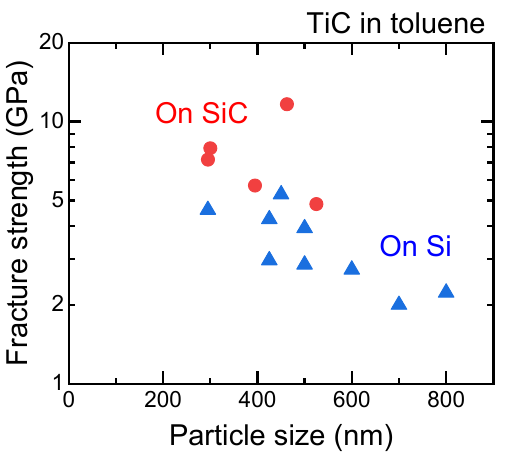
Figure 6. Particle size dependence of fracture strength of TiC SMPs fabricated in toluene. Fracture tests were conducted on SiC and Si substrates indented with a diamond tip.